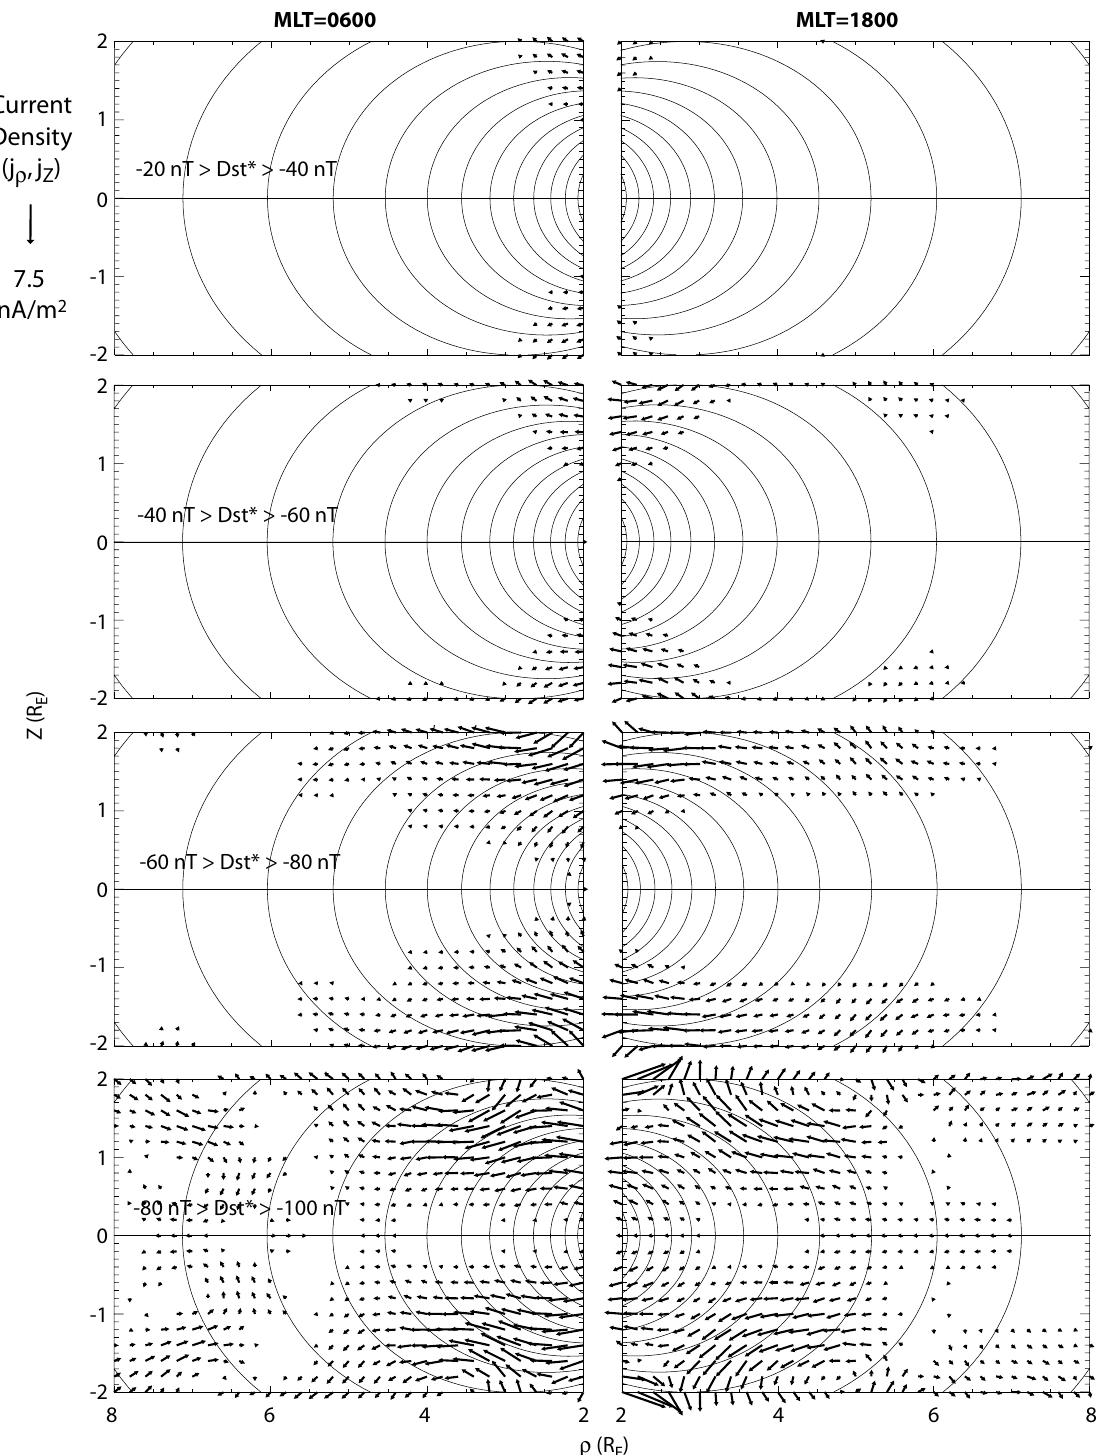
Fig. 11. Meridional components of the current density in the dawn-dusk meridian plane with a constant current vector scale for each of the 4 D st * levels superimposed on dipole field